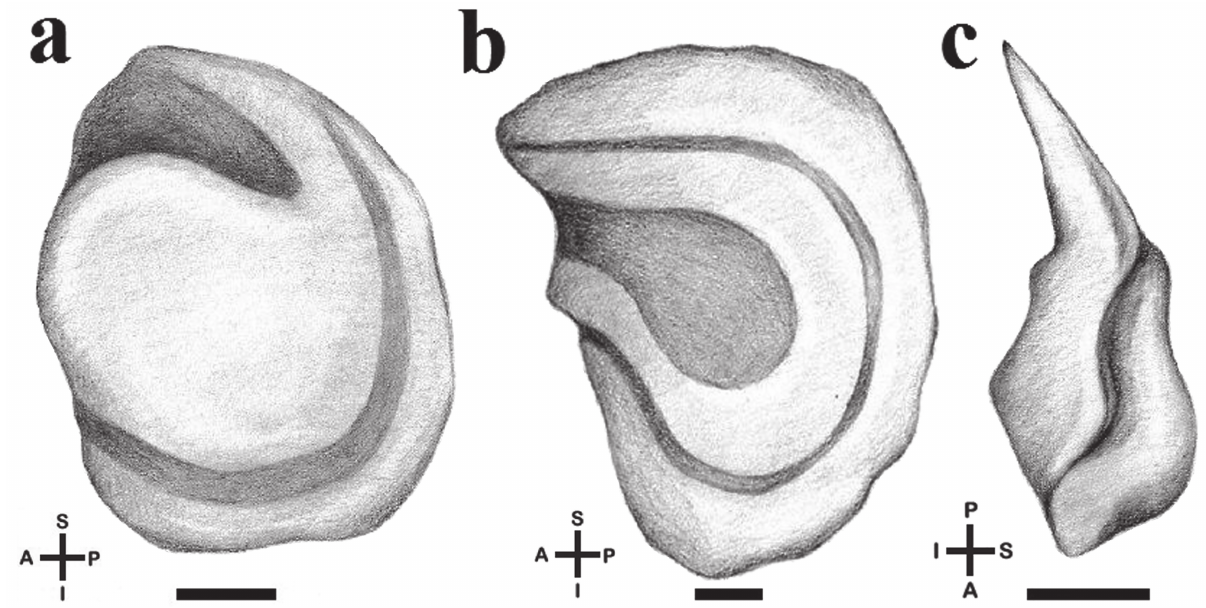
Fig. 6. Right serie of otoliths of Rineloricaria sp. (a) Lapillus, Scale bar = 200 µm; (b) Asteriscus, Scale bar = 200 µm; (c) Sagitta, Scale bar = 200